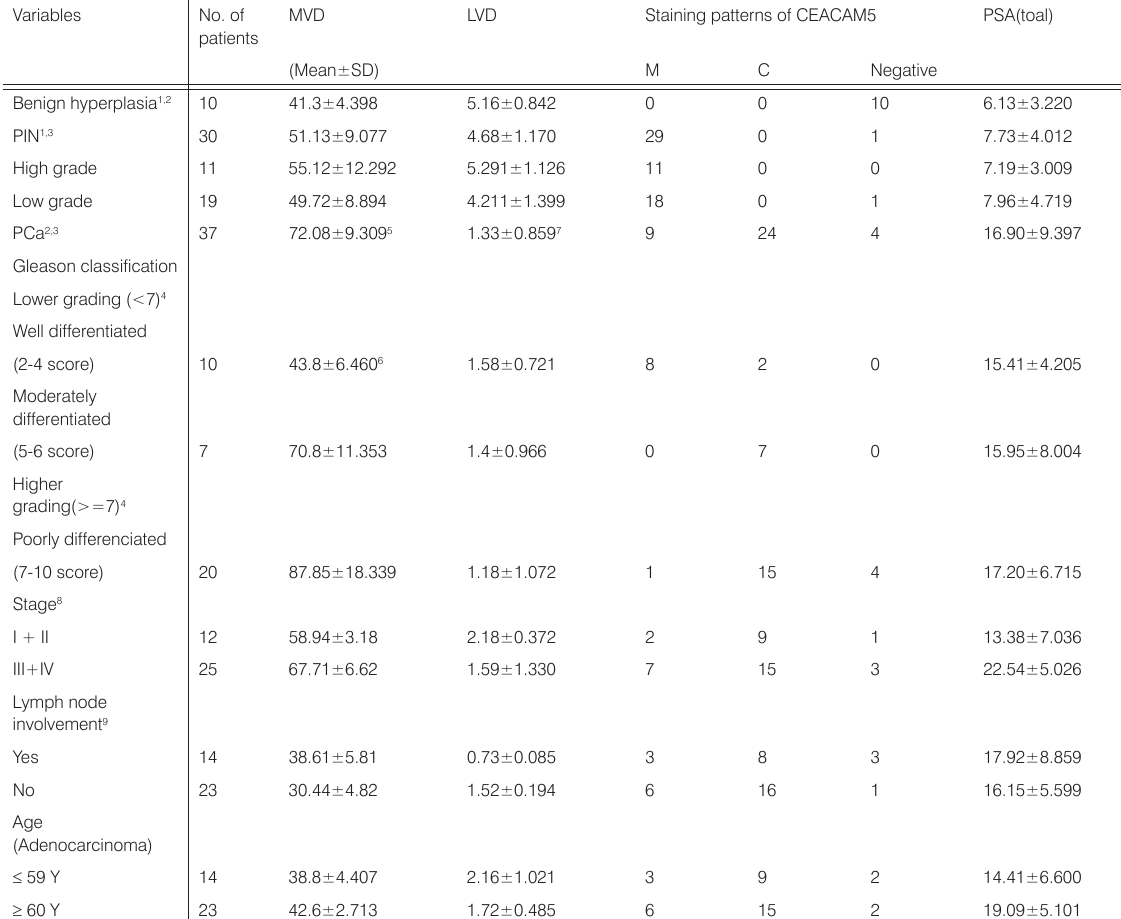
Table 1. ę CEACAM5 expression patterns and its relationship with angiogenesis and lymphangiogenesis in prostatic non-neoplastic and neo- plastic